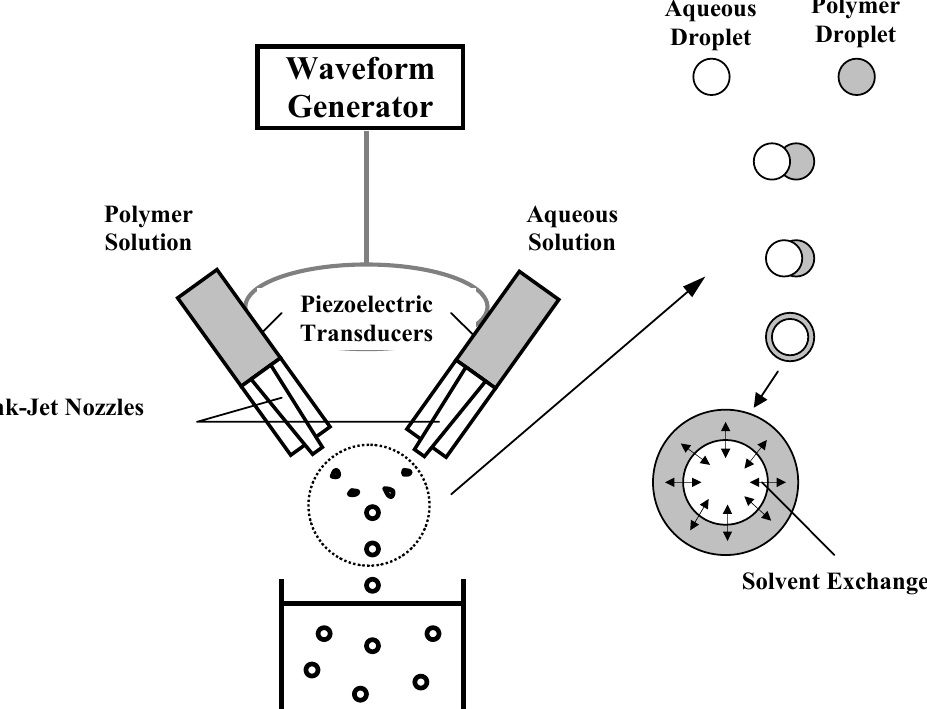
Figure 2. Formation of mononuclear reservoir-type microcapsules by interfacial phase separation. Two different liquid droplets produced from ink-jet nozzles collide each other in the air. The solvent exchange occurs at the interface between two liquids to form a polymer layer on the aqueous core. The formed micro- capsules are collected in the water